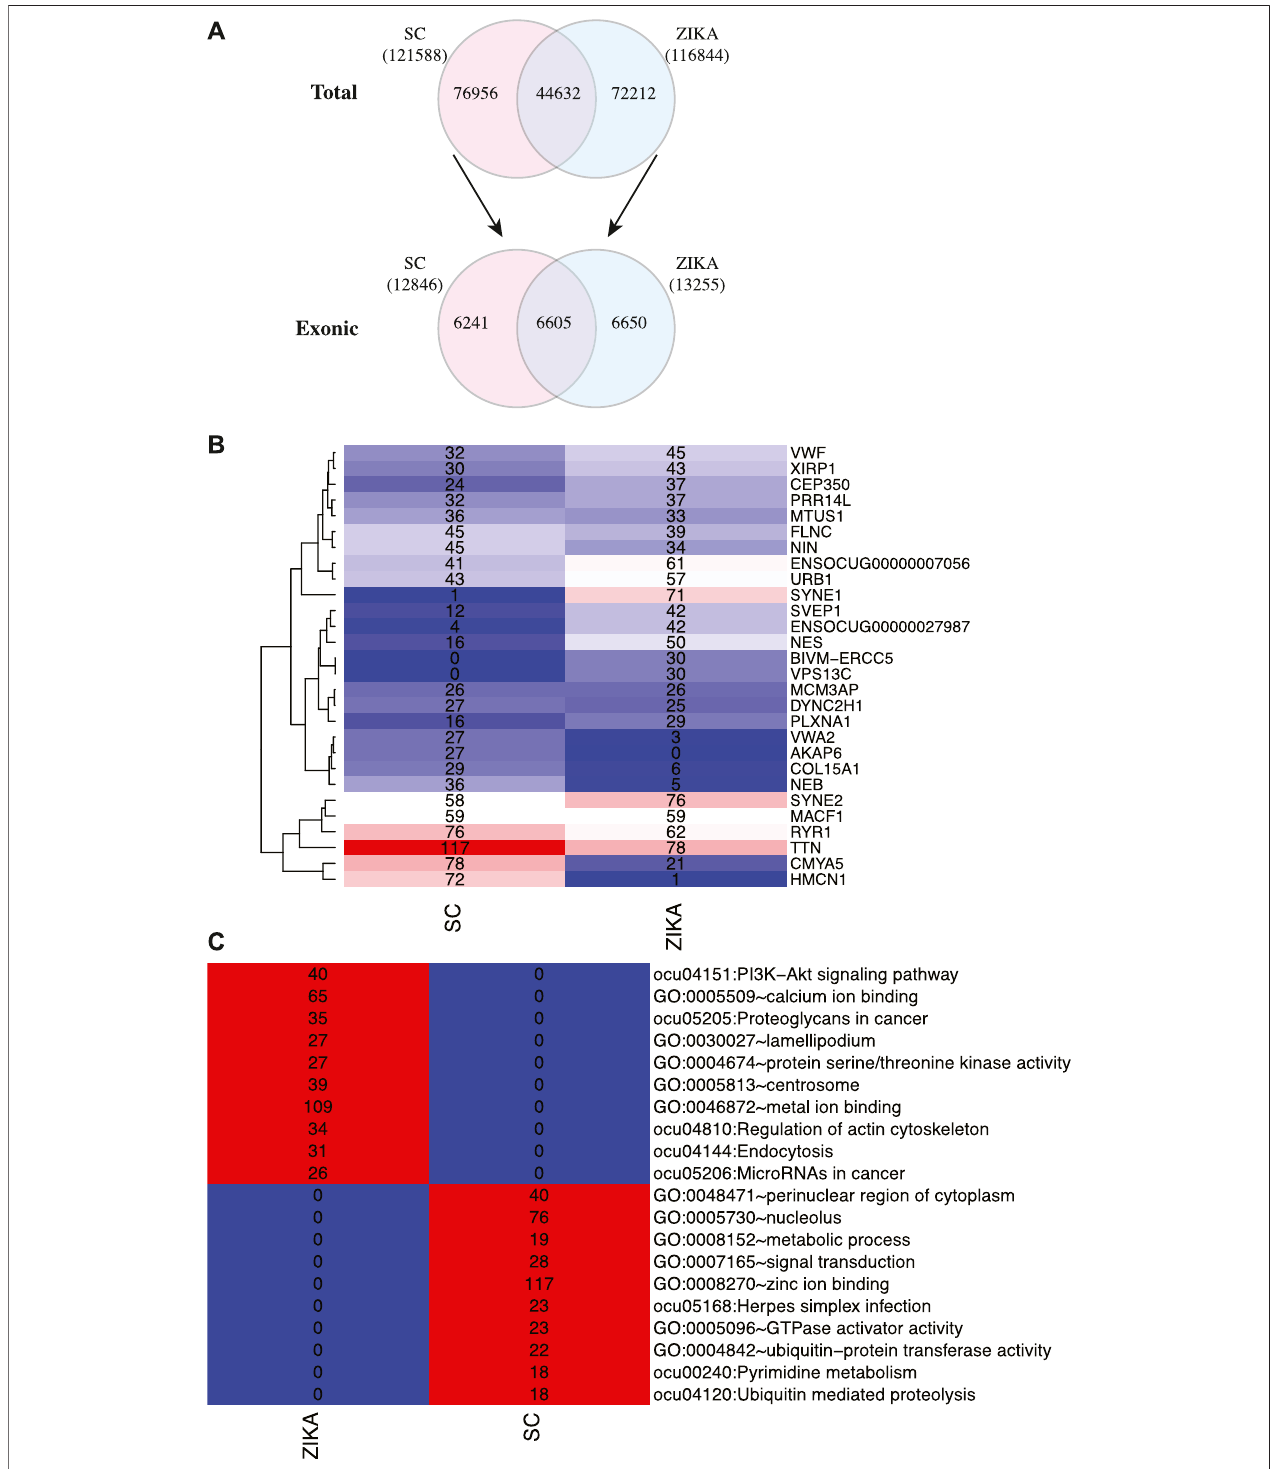
FIGURE 5 | Gene variants identi fi ed in the muscle tissues of SCWrabs and ZIKArabs. (A) Number of total variants and exonic variants identi fi ed in the muscle tissues of SCWrabs and ZIKArabs. (B) Number of mutation events in the top 20 genes. (C) Functional annotation for the mutated genes speci fi cally identi fi ed in the muscle tissues of SCWrabs and ZIKArabs. Values in the blocks represent the numbers of genes involved in the pathways and processes.